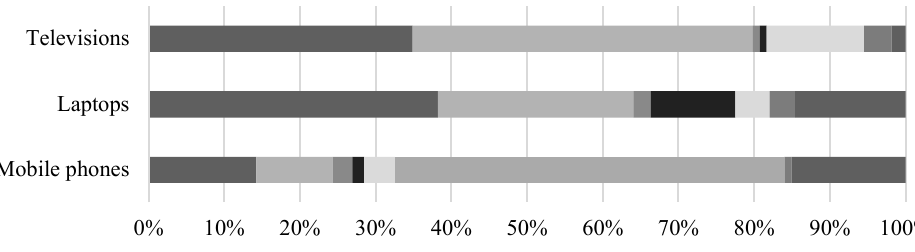
Fig. 1. Percentage of treatment of mobile phones, laptops and televisions waste in Bandung